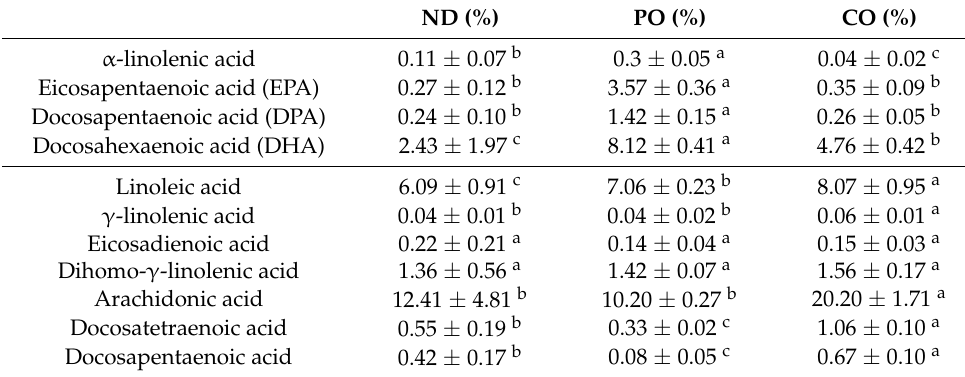
Table 3. Fatty acids composition of the whole blood of